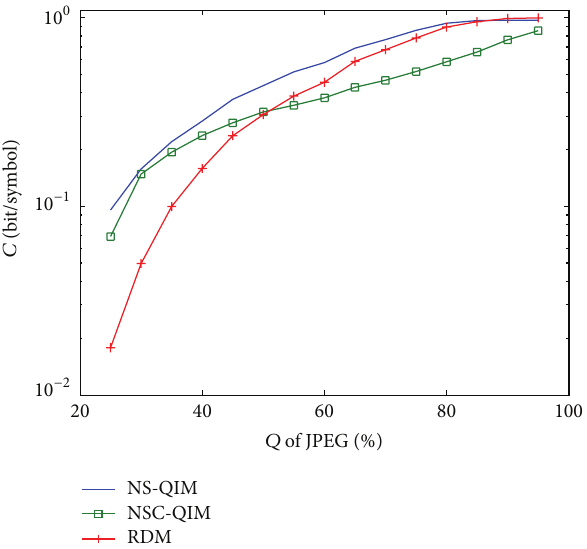
Figure 8: Capacity under GA followed by JPEG compression.